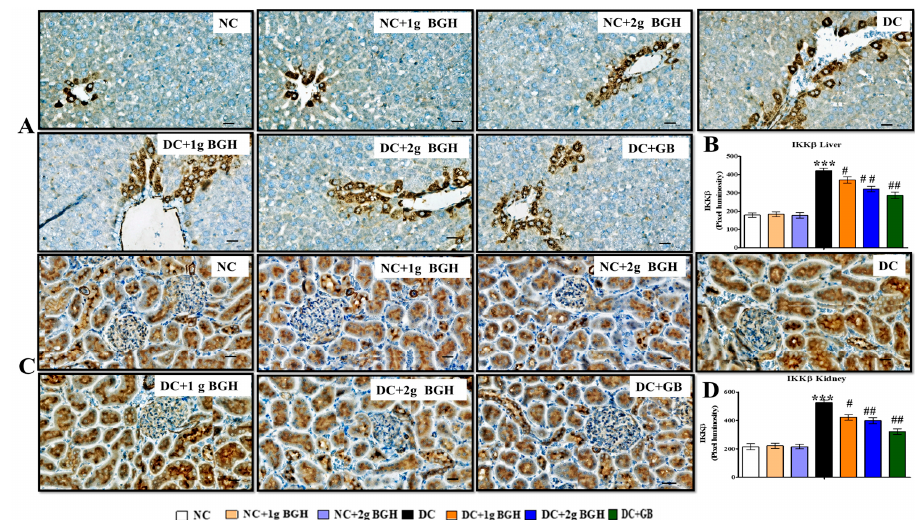
Figure 8. Effect of BGH on the expression of inflammation markers IKK β . Representing immunoperoxidase images showing the distribution of IKK β in the hepatic cells ( A ) and renal cells ( C ). Bar chart showing mean intensity of dark brown staining of IKK β expression in hepatic cells ( B ) and renal cells ( D ). The results were collected from six separate rats within every treatment group and were reported as a mean ± S.E.M. *** p < 0.001 vs. NC; # p < 0.05; ## p < 0.01 vs. DC. Bar scale = 100 μ m. 40× Magnification. NC: Normal control; NC + 1 g BGH: Non-diabetic rats that received 1 g/kg/day BGH; NC + 2 g BGH: Non-diabetic rats that received 2 g/kg/day BGH; DC: Diabetic control; DC + 1 g BGH: Diabetic rats that received 1 g/kg/day BGH; DC + 2 g BGH: Diabetic rats that received 2 g/kg/day BGH; DC + GB: Diabetic rats that received 2 mg/kg/day Glibenclamide.